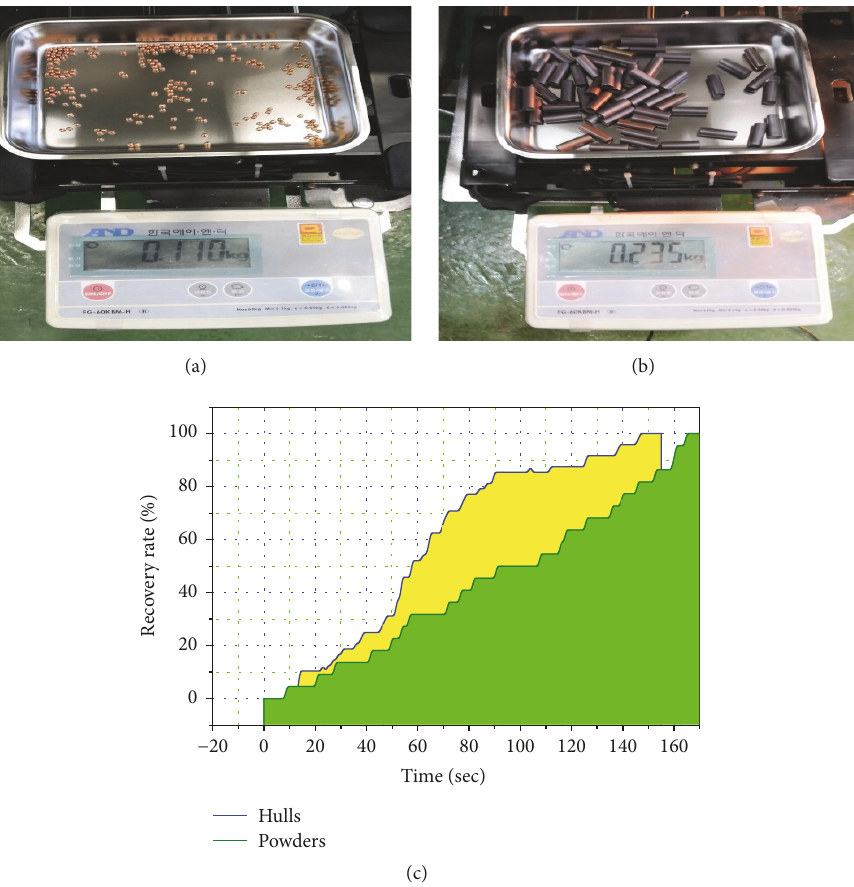
Figure 17: Recovery efficiency of (a) powder (balls) and (b) tubes (zry-4); (c) recovery efficiency over time.